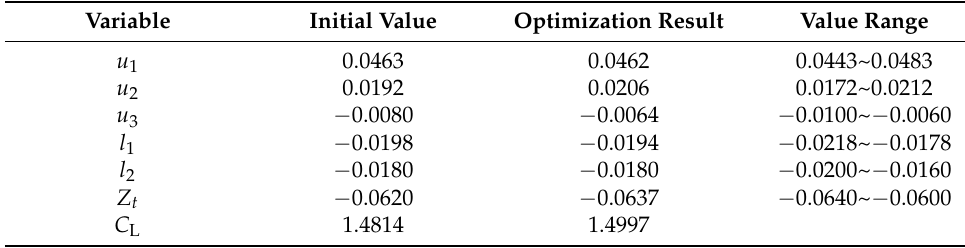
Table 7. Optimization results of airfoil 4 under condition D.